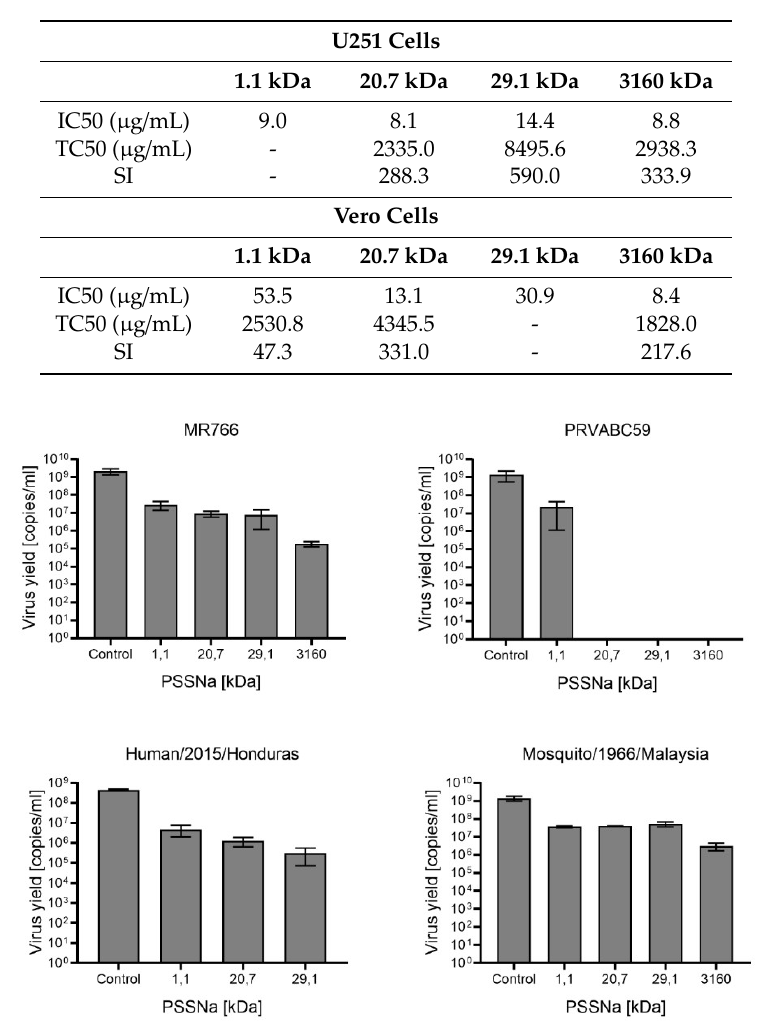
Table 1. Inhibition of ZIKV H / PF / 2013 virus in various cellular models. Experimental values of half-maximal inhibitory concentration (IC50), half-maximal toxic concentration (TC50), and selectivity index (SI) of PSSNa for ZIKV in di ff erent cell lines. The “-” indicates that the given values cannot be determined.